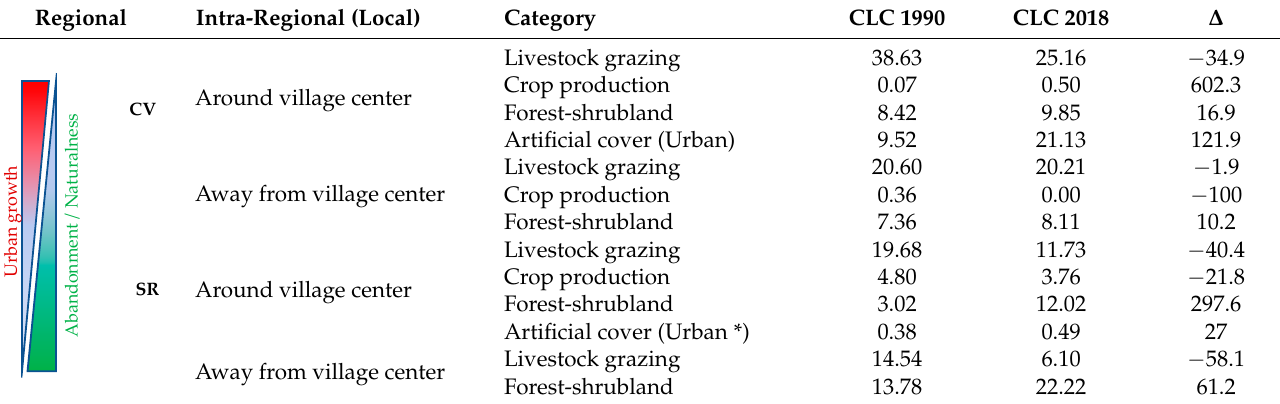
Table 2. Land uses and covers in the study areas based on Corine Land Cover Project (CLC 1990 and 2018), distinguishing between areas ‘around village center’ and ‘away from village’. Two gradients are illustrated: urban growth and natu- ralness/abandonment. ∆ is the rate of change (%) of each land cover between the two periods. CLC 1990 and 2018 are measured in km 2 . CV: Colmenar Viejo and Tres Cantos municipalities; SR: Sierra del Rinc ó n. * Urban cover in SR was estimated from high-resolution aerial imagery for the same dates.